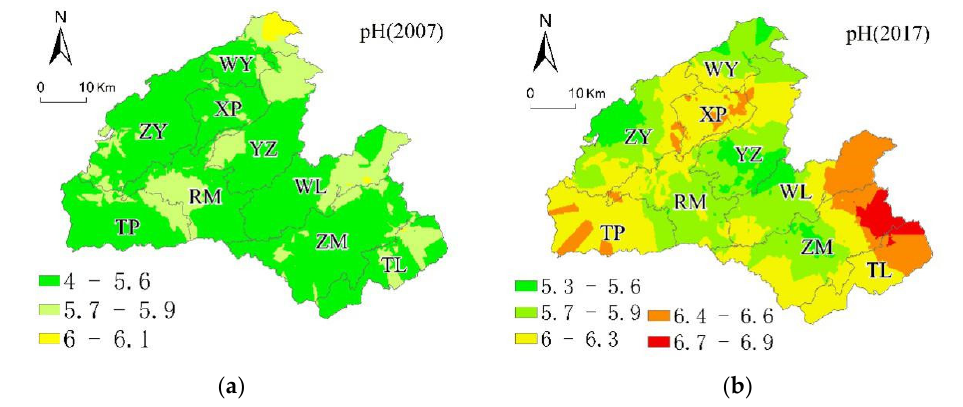
Figure 8. Ordinary kriging distribution maps for ( a ) 2007 pH and ( b ) 2017 pH.